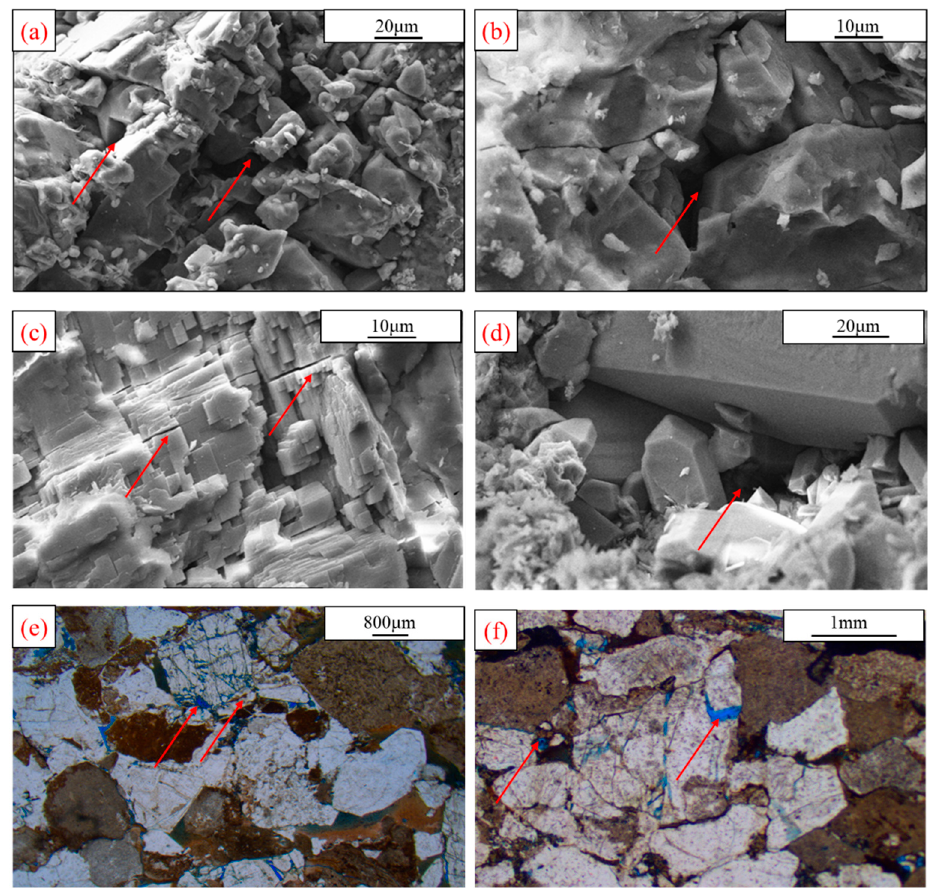
Figure 4. SEM and pore-casted thin section analyses of Well-B3: ( a ) Potassium feldspar dissolution, intragranular pore development, 3853.55 m. ( b ) Intergranular pores between potassium feldspar particles, 3855.06 m. ( c ) Calcite dissolution forms microfracture, 3855.76 m. ( d ) Autogenic quartz filling intergranular pores, 3854.62 m. ( e ) Gravel structure, debris particles are mostly sub-circular– sub-angular, development of dissolution pores and microfracture, 3853.29 m. ( f ) Development of inter grain dissolved pores and intergranular dissolved pores, 4049.87 m.